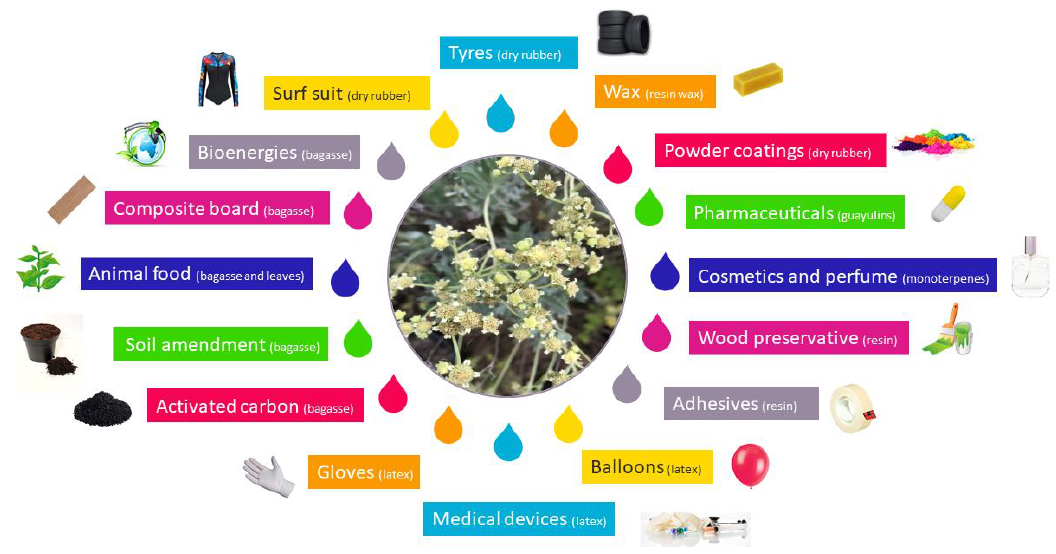
Figure 11. Proposed applications for products and co-products of guayule processing.